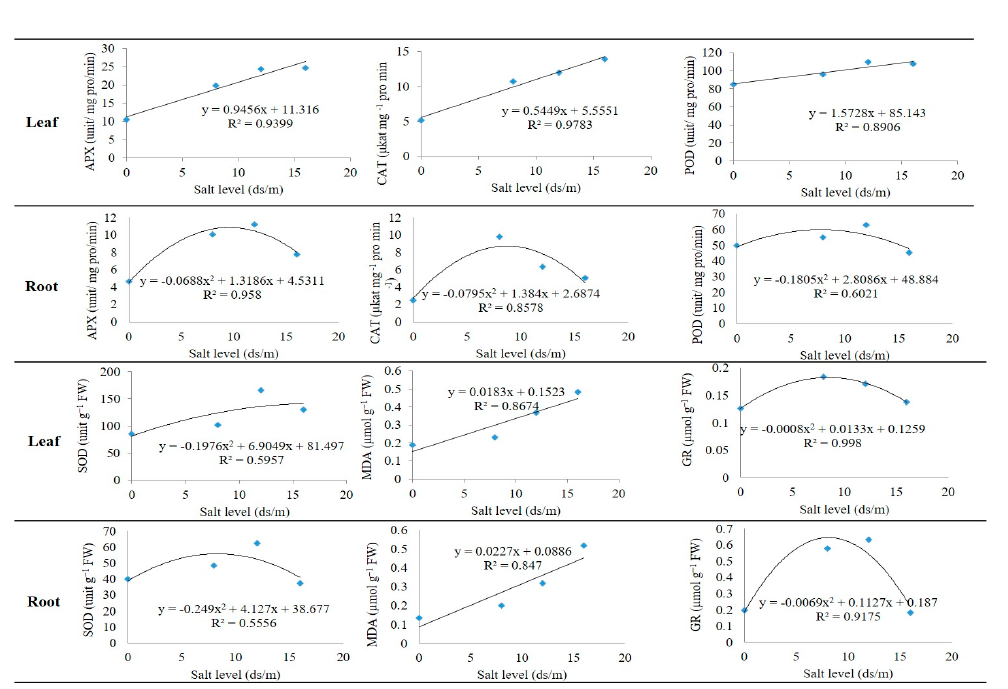
Figure 13. Linear and quadratic models of SOD, POD, CAT, APX, GRT, and MDA indices in leaves and roots of pistachio rootstock.